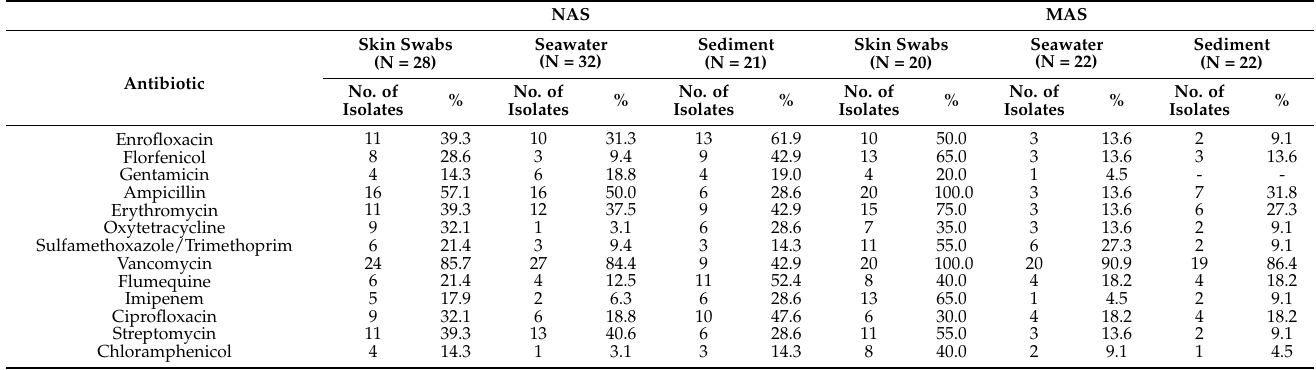
Table 6. Differences in antibiotic resistance of the bacterial isolates from the NAS antibiotic-free European seabass farm versus farm MAS conventional farm.